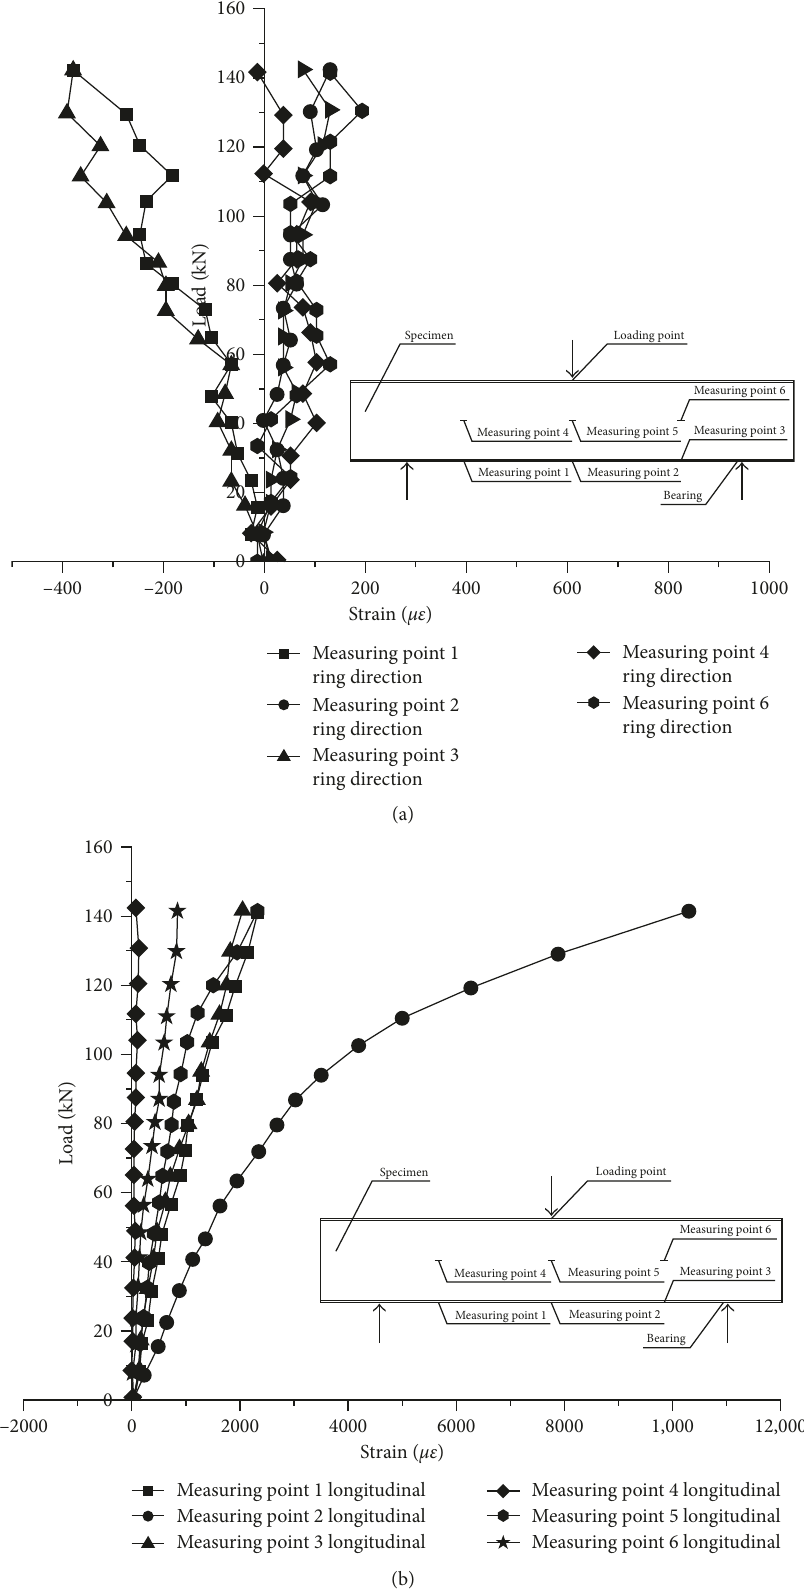
Figure 11: (a, b) Strain-load curves for each measuring point of specimen